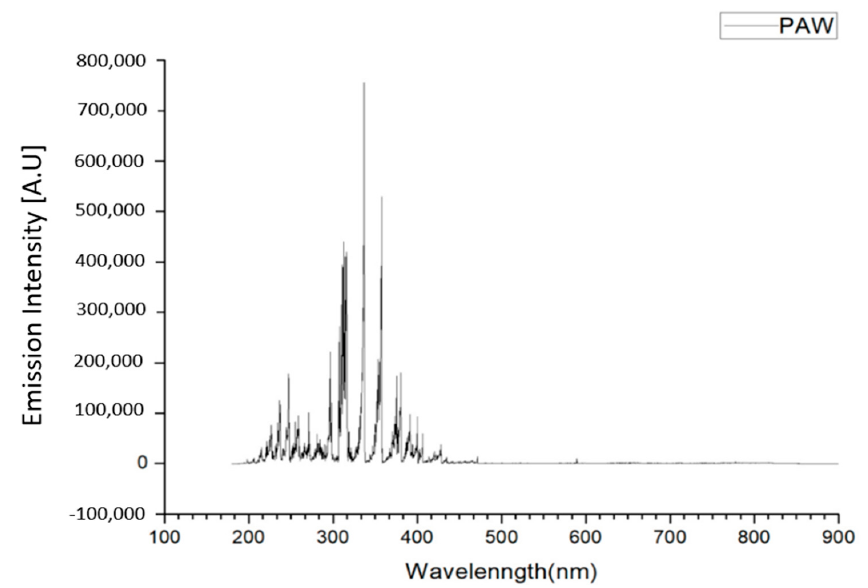
Figure 2. Space-integrated optical spectra of the plasma for water activation.